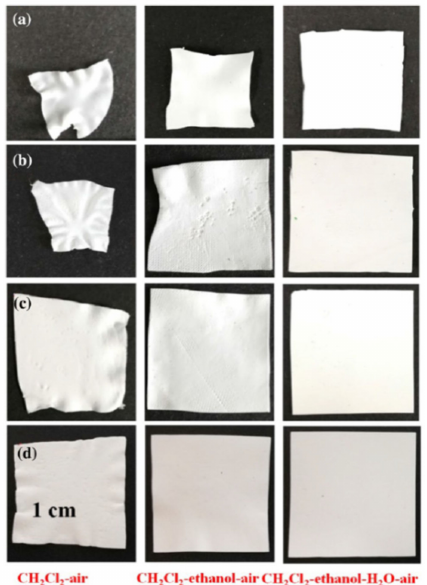
Figure 10. Digital images of the membranes with different annealing times; the membranes were dried by CH 2 Cl 2 -air (left), CH 2 Cl 2 -ethanol-air (middle), and CH 2 Cl 2 -ethanol–water–air (right), respectively; ( a ) is UHMWPE membrane annealing for 0 min, ( b ) is annealing for 5 min, ( c ) is annealing for 15 min, and ( d ) is annealing for 25 min. Reproduced with permission from J. Quan, Q. Song, J. Yu, Y. Wang, J. Zhu, Z. Hu, Advanced Fiber Materials, Published by Springer-Nature,